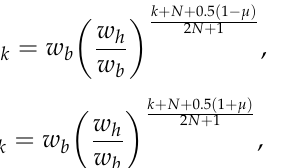
system. Figure 12 is the FOPID control plane diagram.